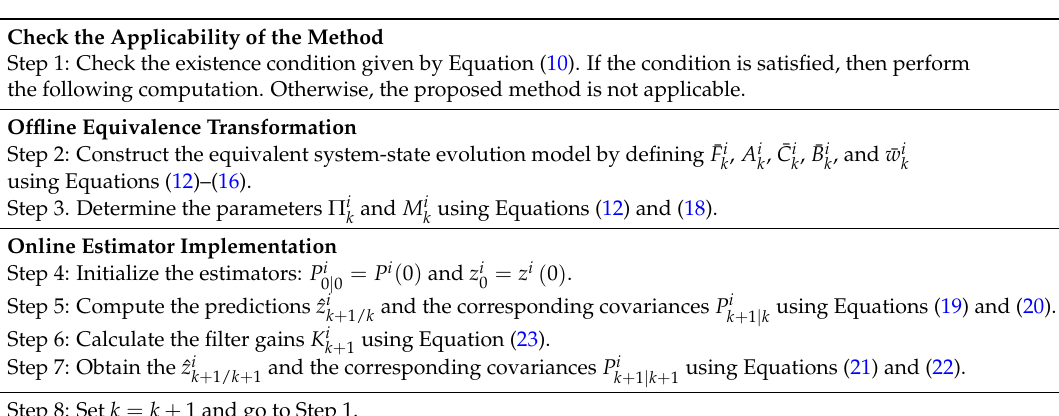
Figure 2. The scheme of joint MMSE estimation of the state and the SB. Table 1. Pseudo-code for the local MMSE